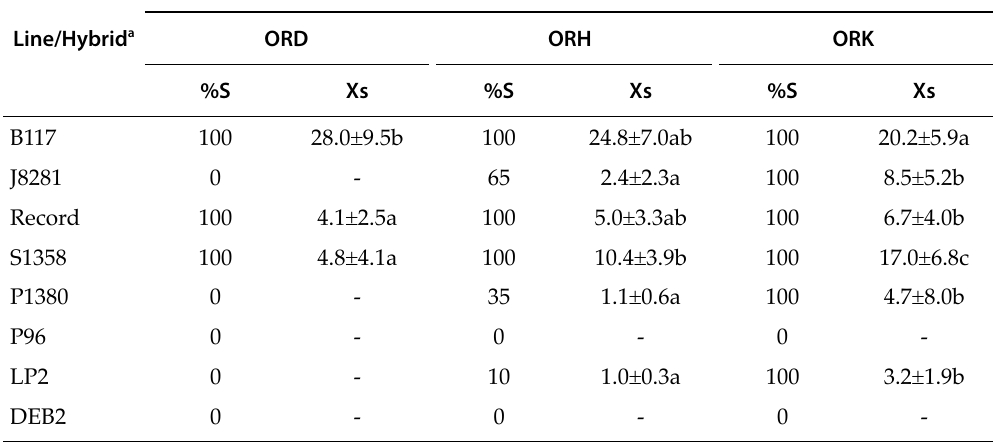
Table 1. Mean percentage of susceptible plants (%S) and average number of sunflower broomrape shoots in susceptible plants (Xs, mean ± standard deviation) in eight differential inbred lines of sunflower inoculated with three broomrape populations collected from Tunisia (ORD, ORH and